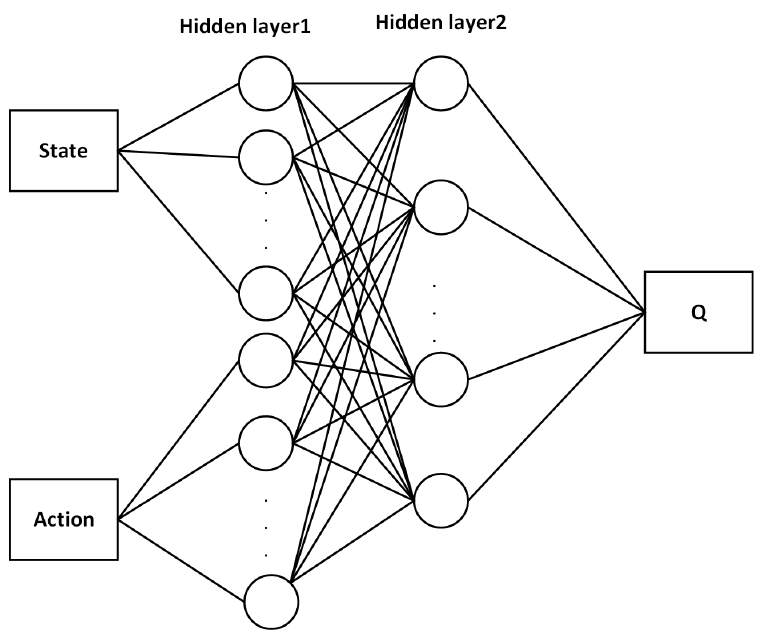
Figure 7. The schematic diagram of the target